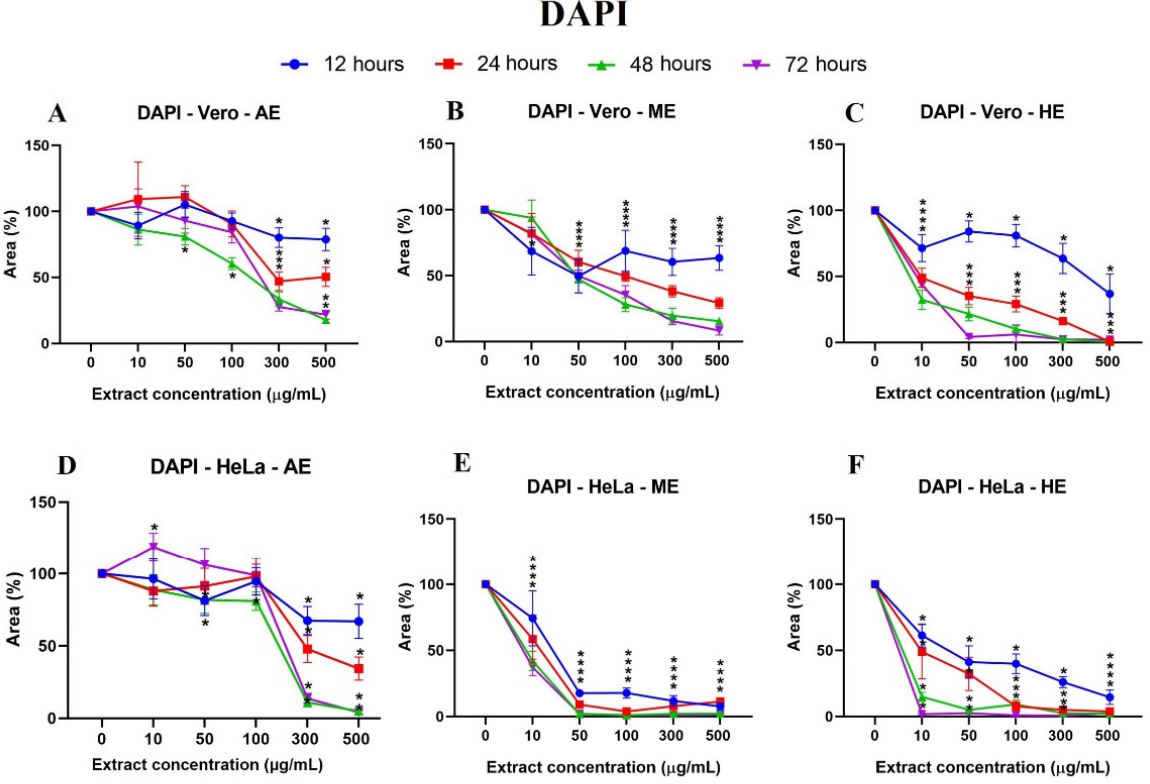
Figure 6. Cell behavior against different concentrations of A. monostachya extracts by nuclei labeling with DAPI. Comparisons of the effects of AE, ME, and HE on the cell lines: Vero ( A – C ), HeLa ( D – F ), and MDA-MB-231 ( G – I ) after exposure to the extracts at 12 h (blue line), 24 h (red line), 48 h (green line), and 72 h (purple line). The graphs show the % area as a function of the concentration of the extracts. It can be seen that HE has a greater cytotoxic effect on the tumor cell lines at 24 h and later. The HeLa cells showed a lower percentage of the area after exposure to the extracts. * p < 0.05, Tukey’s multiple comparison test vs. vehicle-treated cells. 2.5. A. Monostachya Extracts Decrease the Viability in Human Tumor Cells In addition to quantifying viable cells by establishing a relationship with cell adhesion, we decided to perform an MTT assay to correlate mitochondrial activity with viability and thus observe cell energy metabolism behavior against the extracts. In this case, viable cells were able to metabolize the tetrazolium salt and reduce it to obtain the formazan, a purple-blue compound, whose absorbance readings allowed us obtain the following results: At 24 h, the results were similar to those observed at 12 h: AE showed significant differences against the control cell line when treated with the concentration of 300 µg/mL, and interestingly, ME and HE showed a cytotoxic effect from the concentration of 50 µg/mL onwards. At this exposure time, a concentration-dependent response began to be observed. In contrast, MDA-MB-231 cells showed resistance and, in some cases, higher relative viability than the Vero cell line (Figure 7). The longer the exposure time (48 and 72 h) to the three extracts, the more decreased the relative viability was (Figure 8).